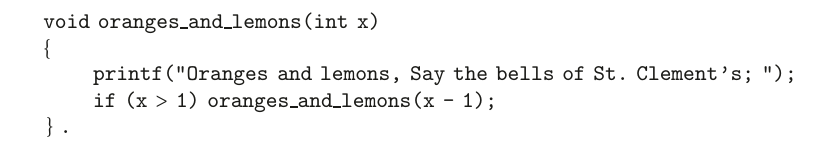
Algorithm 1: A simple recursive function showing how, via computing, it is possible to create repeated (redundant) copies of “Oranges and lemons, Say the bells of St.